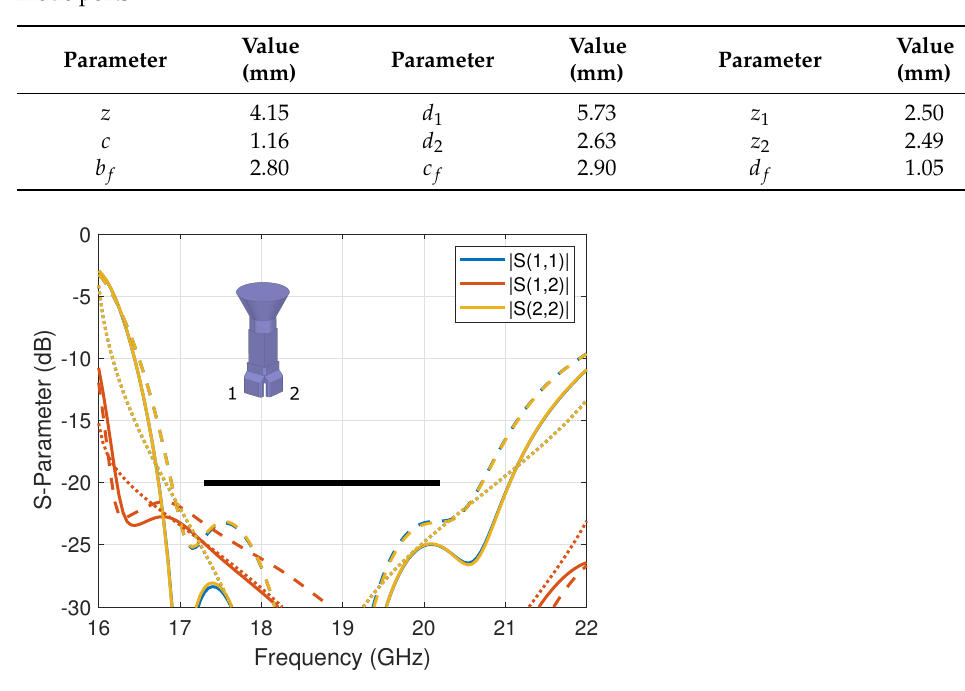
Figure 5. Isometric CAD view of the proposed very compact waveguide OMT with folded single- mode ports ( left ) and associated additional design parameters in side CAD ( top right ) and bottom CAD views ( bottom right ). Table 2. Design parameters of the very compact waveguide OMT in the K-band with folded single- mode ports.